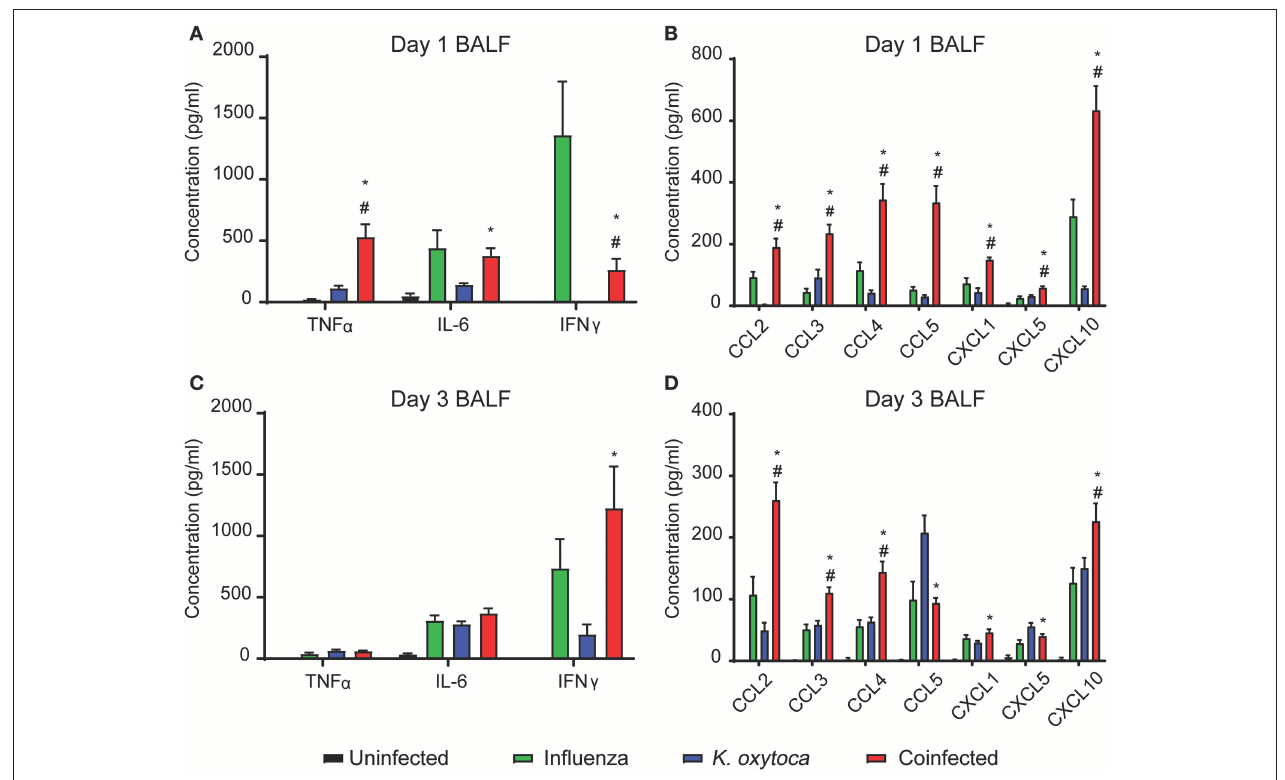
FIGURE 1 | Coinfected mice exhibit increased inflammation early after bacterial infection. Protein concentrations of a panel of cytokines and chemokines were measured in the bronchoalveolar lavage fluid (BALF) of mice on days 1 and 3 following K. oxytoca infection (days 8 and 10 following IAV). Day 1 cytokine levels (A) and chemokine levels (B) are depicted for all 4 groups. Day 3 cytokine (C) and chemokine (D) levels are depicted for all 4 groups. # denotes P ≤ 0.05 between coinfected and IAV groups. * denotes P ≤ 0.05 between coinfected and K. oxytoca groups. Data were analyzed with ANOVA followed by Tukey’s multiple comparison tests. Error bars represent SEM. Data are combined from at least four independent experiments with at least four mice per